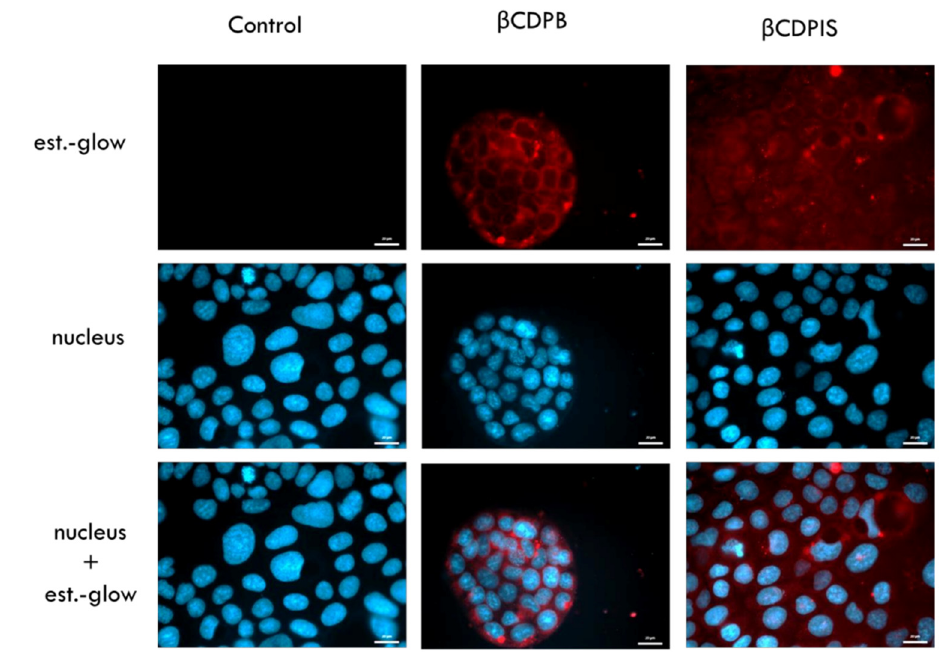
Figure 12. Fluorescence microscopy images of estradiol-glow uptake after 2 h of incubation on Caco-2 cells. Estradiol-glow accumulated in the cytoplasm (red) after incubation indicating that it liberated from the carrier and reached the cellular target. Control: cells were treated with PBS without estradiol-glow. Blue: cell nuclei, red: estradiol-glow. Scale bar: 20 µm.